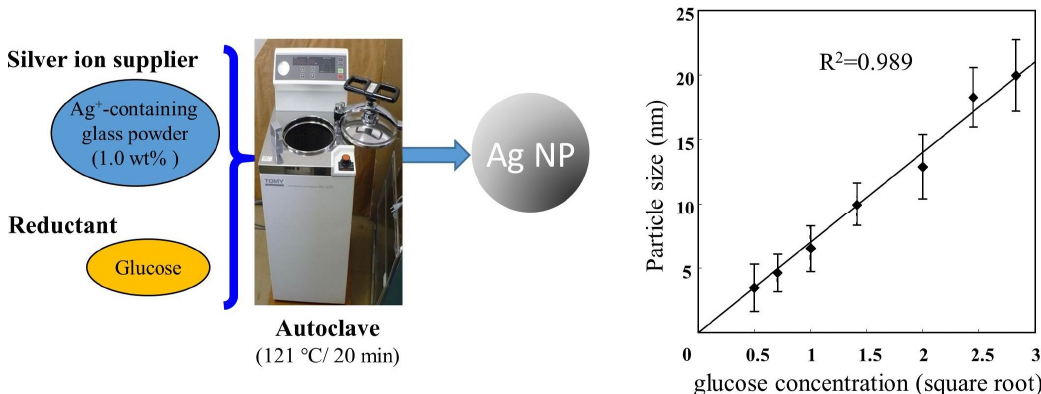
Figure 2. Environment-friendly method for Ag NP synthesis with the diameters control by glucose concentration. We have reported that environment-friendly processes were used to produce small Ag NPs ( < 10 nm) within a narrow size distribution. The diameters of generated Ag NPs were easily controlled by glucose concentrations [14].